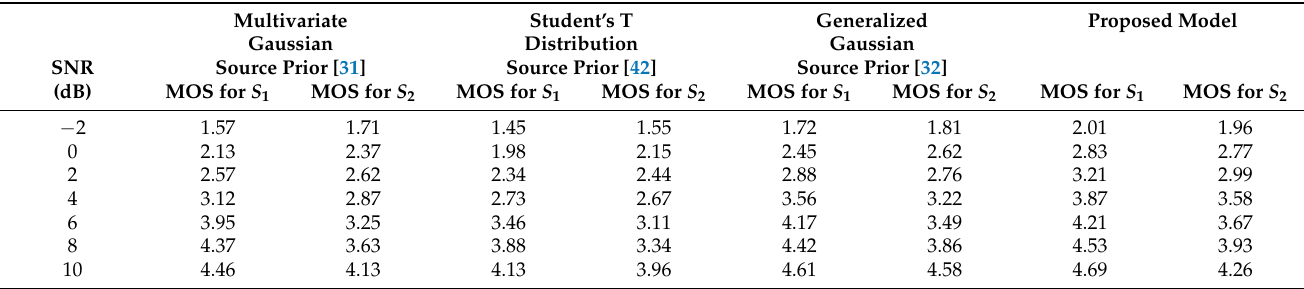
Table 5. Average MOS results of the subjective evaluation for the first model shown in Figure 1 with variable SNR for multistage BSS models having different source priors.